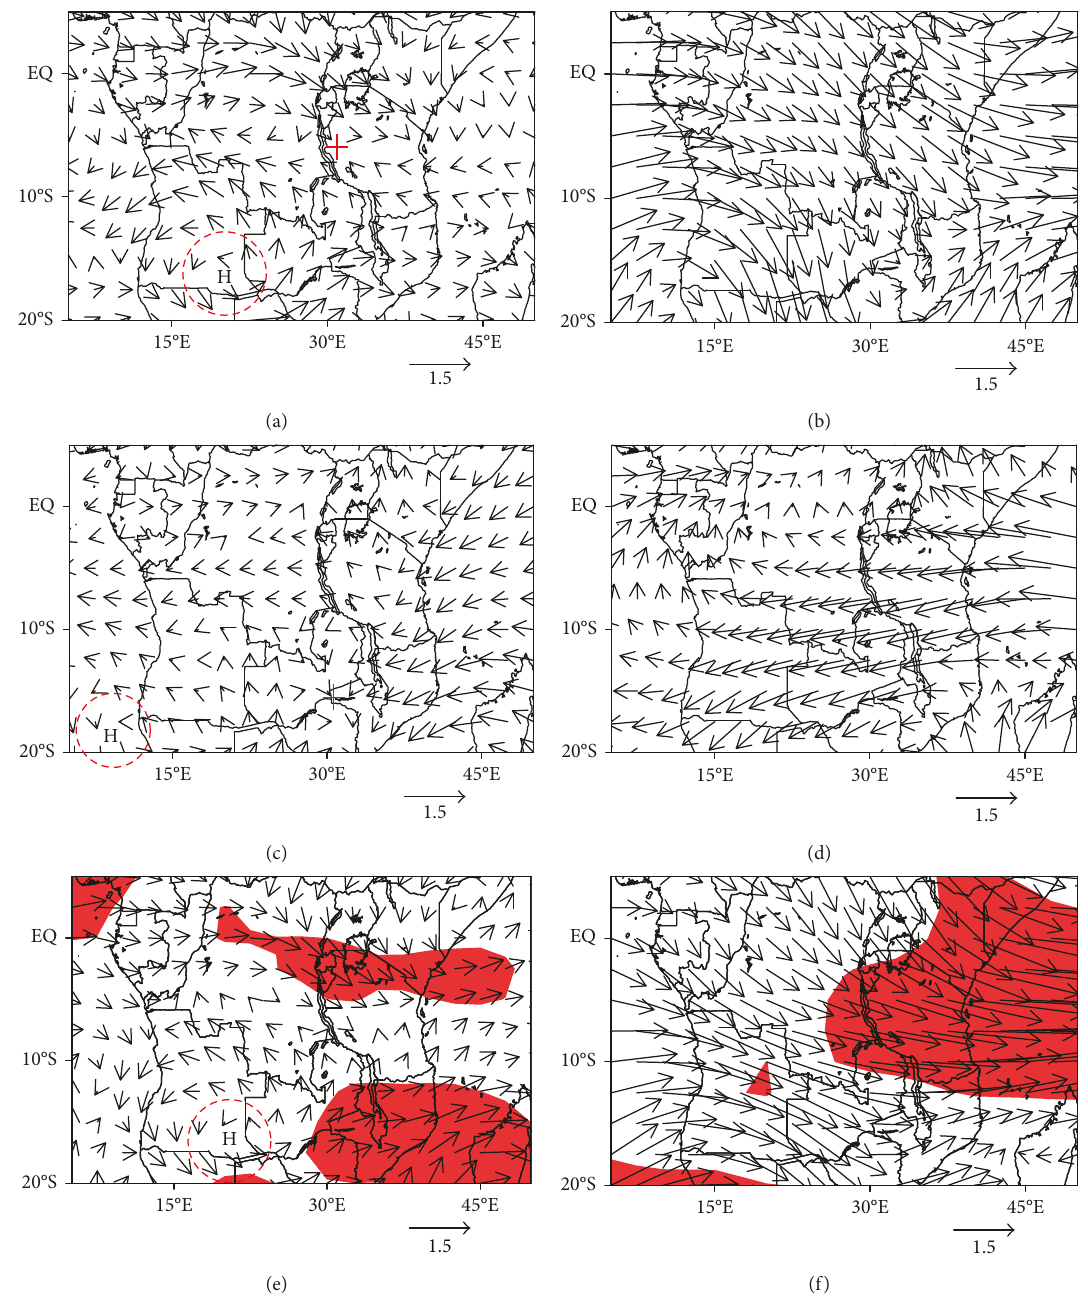
Figure 6: Composite wind vector anomalies for anomalous HREs than normal years at (a) 850hPa and (b) 200 hPa; suppressed HREs than normal years at (c) 850hPa and (d) 200hPa; the difference between anomalous and suppressed HREs at (e) 850hPa and (f) 200hPa. Shaded areas are significant regions at t -test based on 95% confidence